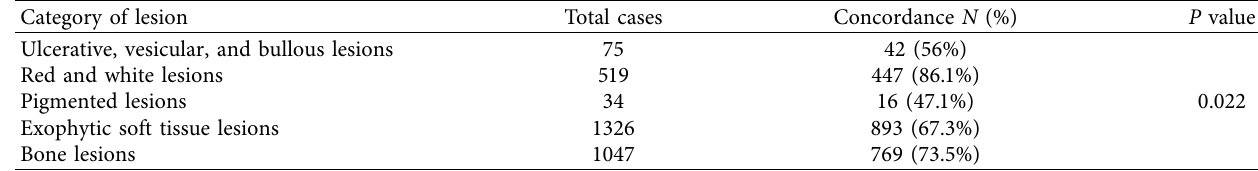
Table 3: Concordance rate of clinical and histopathologic diagnosis based on the type of lesions.